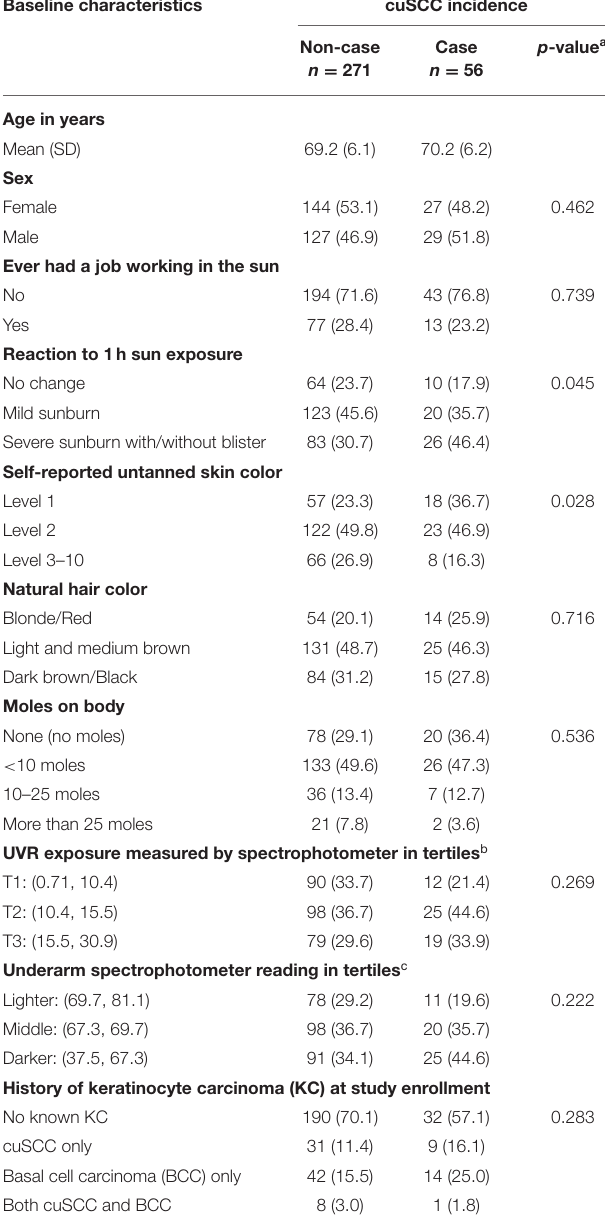
TABLE 1 | Baseline characteristics of 327 skin cancer screening patients enrolled in year 1 of the VIRUSCAN Study compared between those that subsequently developed cutaneous squamous cell carcinoma (cuSCC) and those that did not. Baseline